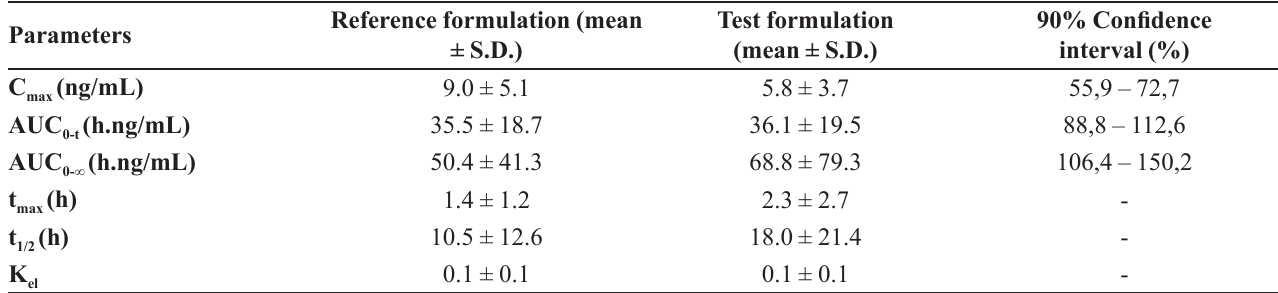
C : peak concentration; AUC max AUC : area under the curve from zero to infinity; t 0-∞ S.D.: standard deviation